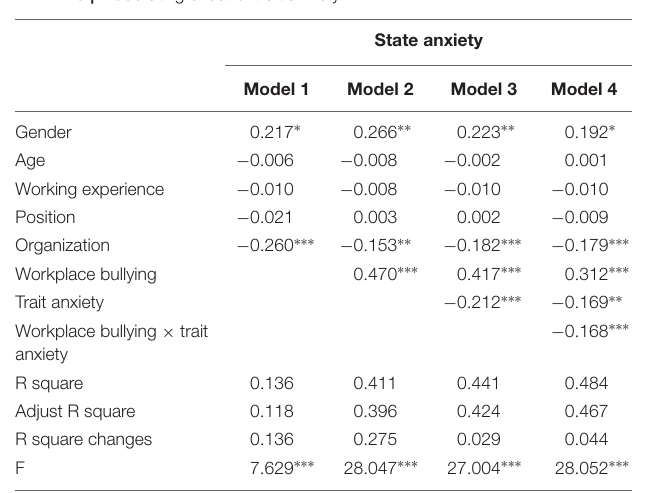
TABLE 3 | Moderating effect of trait anxiety.